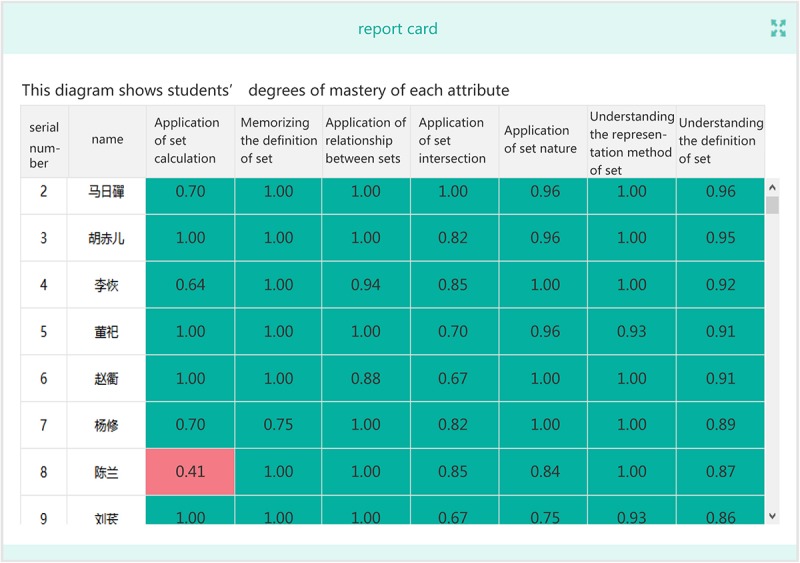
Student’s mastery of each attribute.